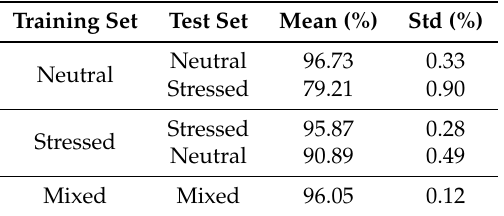
Table 3. Results for matched and mismatched